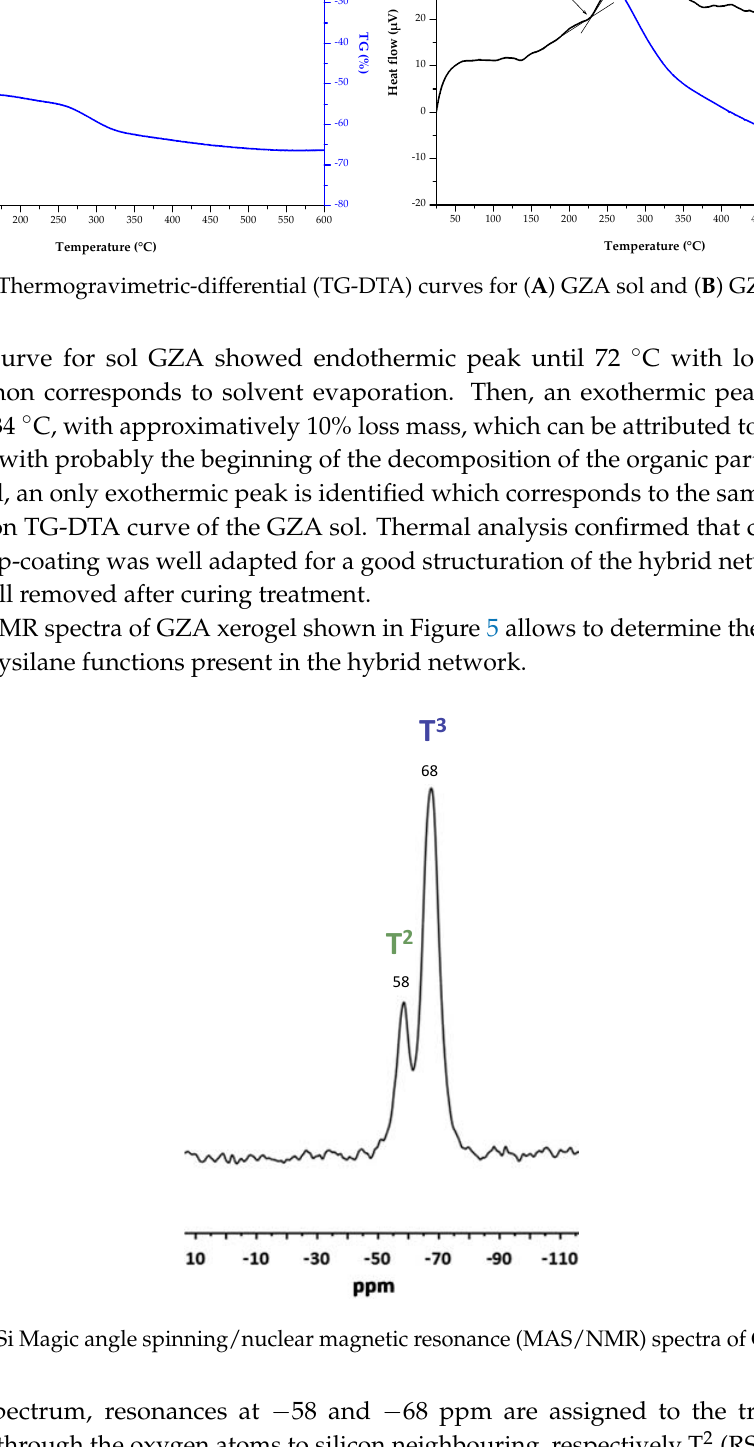
Figure 5. 29 Si Magic angle spinning/nuclear magnetic resonance (MAS/NMR) spectra of GZA xerogel. On this spectrum, resonances at − 58 and − 68 ppm are assigned to the trifunctional unit interconnected through the oxygen atoms to silicon neighbouring, respectively T 2 (RSi(OSi) 2 (OH) and T 3 (RSi(OSi) 3 ) (Figure 6).